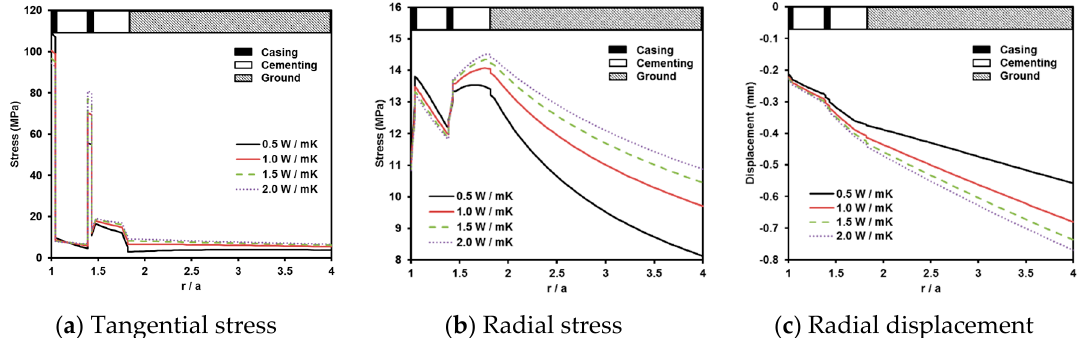
Figure 7. Stress and displacement at 1000m with variation of thermal conductivity of the cementing component.